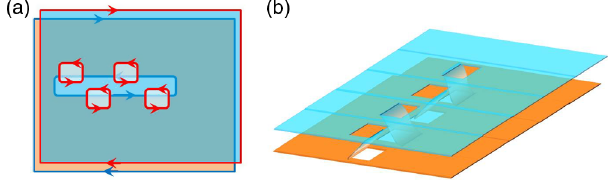
FIG. 5. Alternating the offset of the top and bottom gate will allow us to generate an energy gap for all edge states. At long wavelengths, both twisted tunneling terms, simultaneously